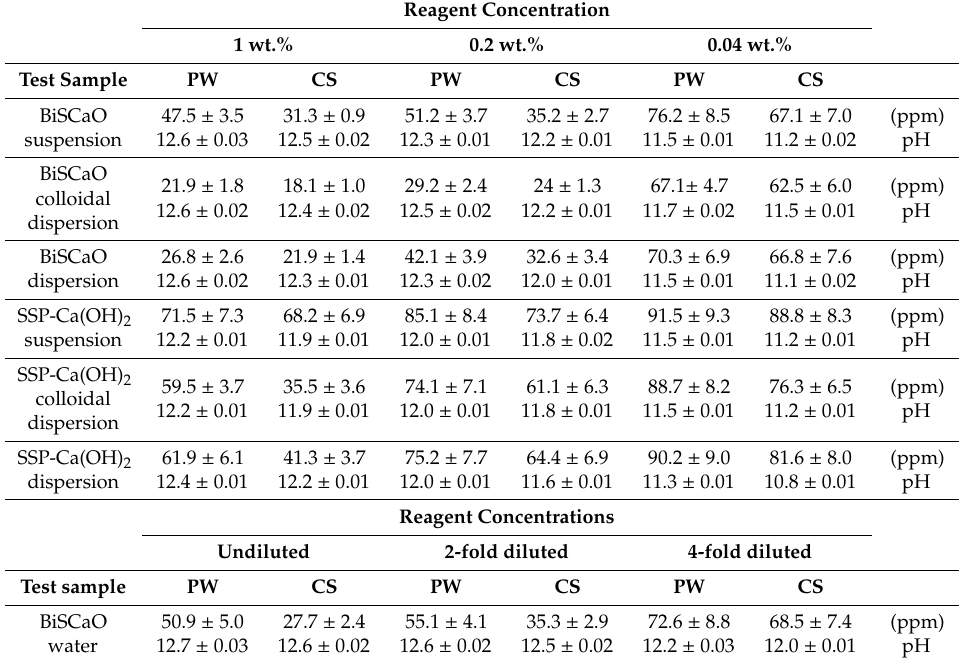
Table 1. Reduction of histamine concentration (ppm) in pure water (PW) and contaminated saline (CS) by various BiSCaO-based disinfectants ( n =